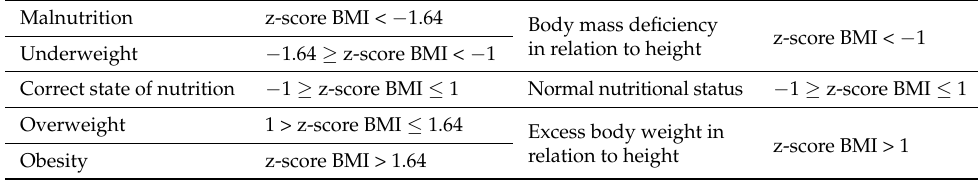
Table 3. Classification of nutritional status based on the z-score BMI. Malnutrition z-score BMI < −